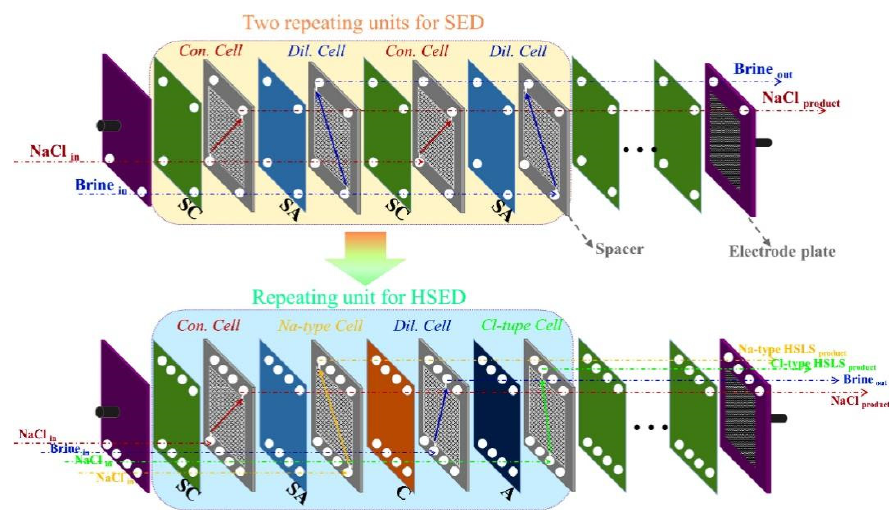
Figure 3. Structural diagram of SED and HSED stacks [31].